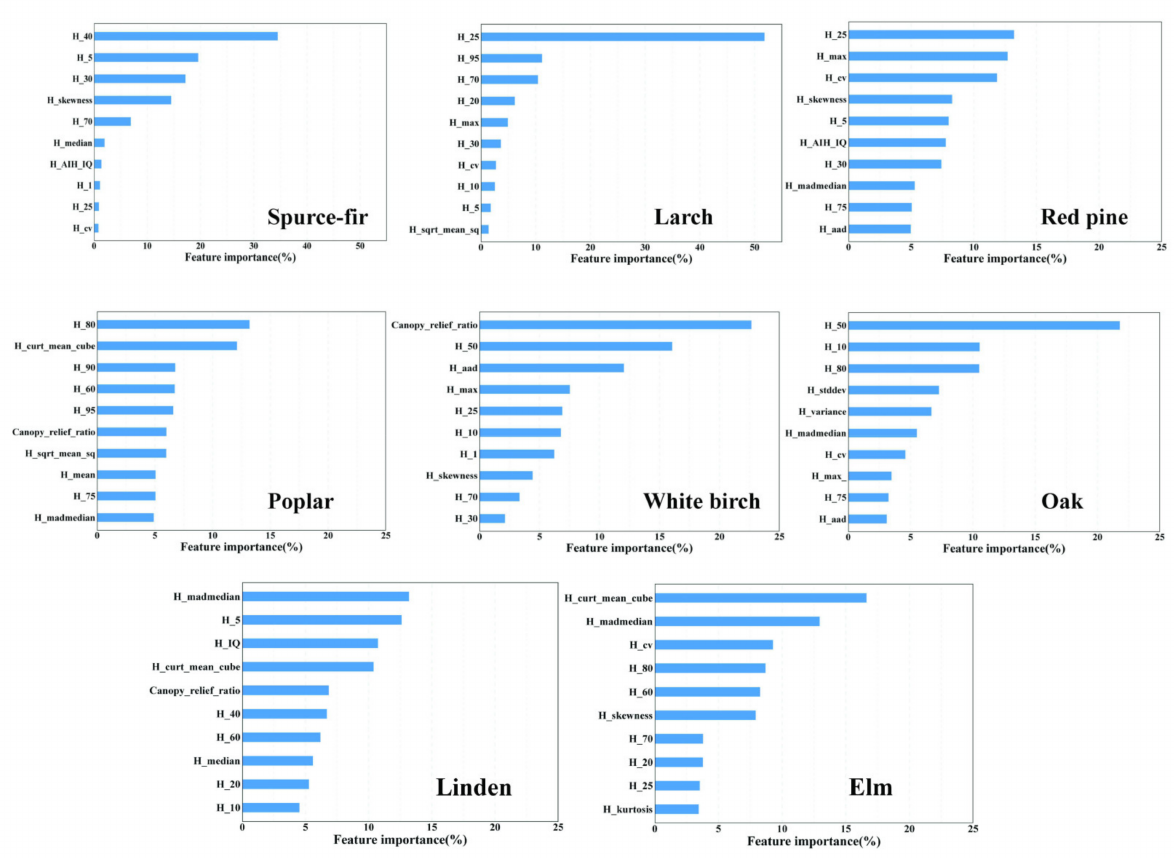
Figure 9. Relative importance of the 10 highest ranked variables of CatBoost models based on